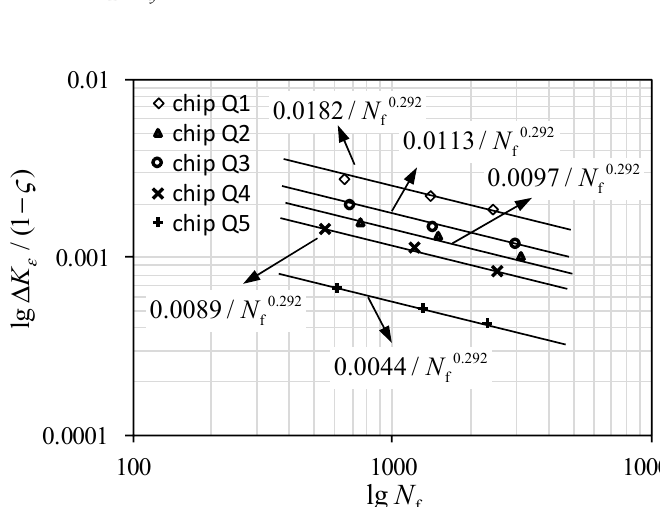
Figure 12. Relationship between ∆ K ε / ( 1 − ς ) and N f